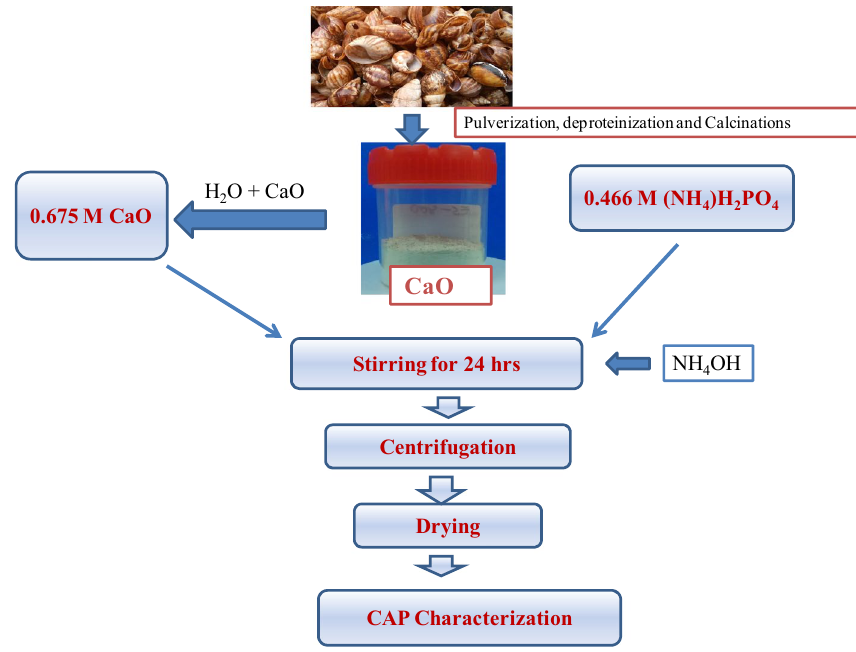
Fig. 1 Flow chart for the syn- thesis of CAP from snail